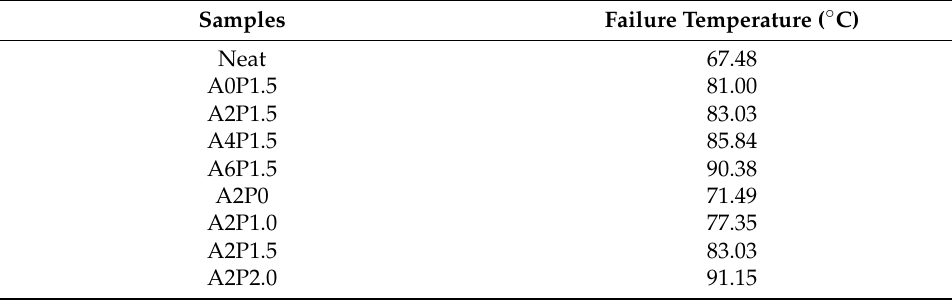
Figure 8. Variations in G*/sin δ with temperature for composite modified binders: ( a ) composite modified binders with various contents of APAO; ( b ) composite modified binders with various contents of PPA. Table 7. Failure temperatures of all tested specimens.